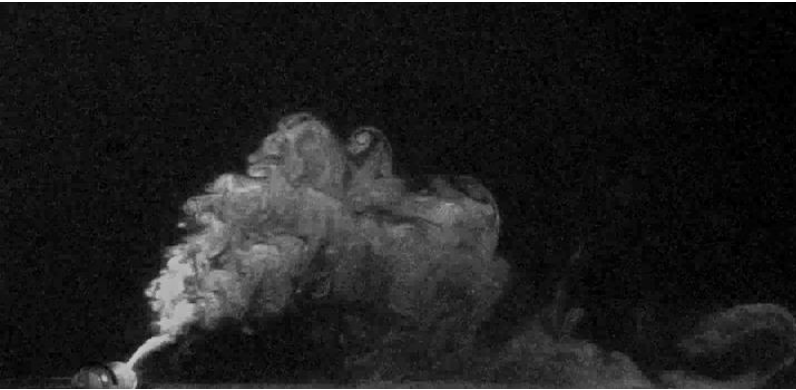
Figure 3. An instantaneous visualization of the concentration field for the same inclined NBJ of Figure 2 released into a receiving body affected by regular waves with A = 12.5 mm and T = 1.00 s.